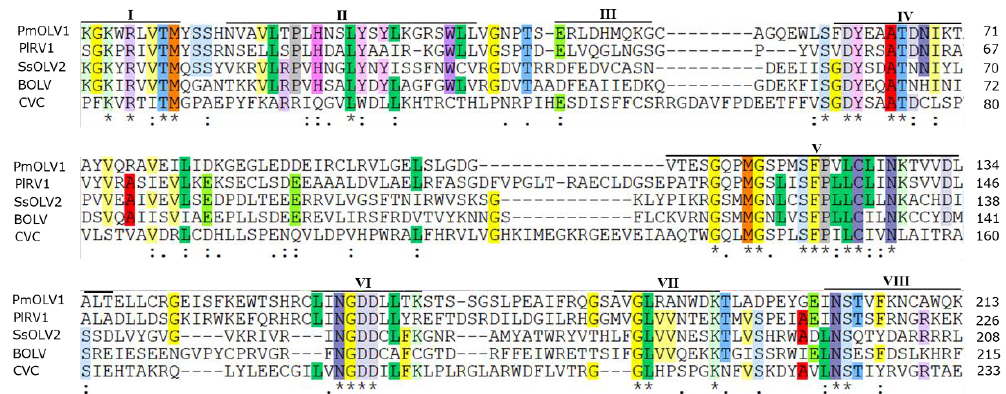
Figure 2. Multiple alignment of amino acid sequences of RNA-dependent RNA polymerase (RdRp) proteins encoded by PmOLV1 and other selected viruses. Horizontal lines above the alignment indicate the eight motifs by roman numerals I to VIII. Abbreviations: PlRV1, Phomopsis longicolla RNA virus 1; SsOLV2, sclerotinia sclerotiorum ourmia-like virus 2; BOLV, botrytis ourmia-like virus 1; CVC, Cassava virus C. Asterisks, colons, and dots show the same amino acid residues, conservative, and semi conservative, respectively.